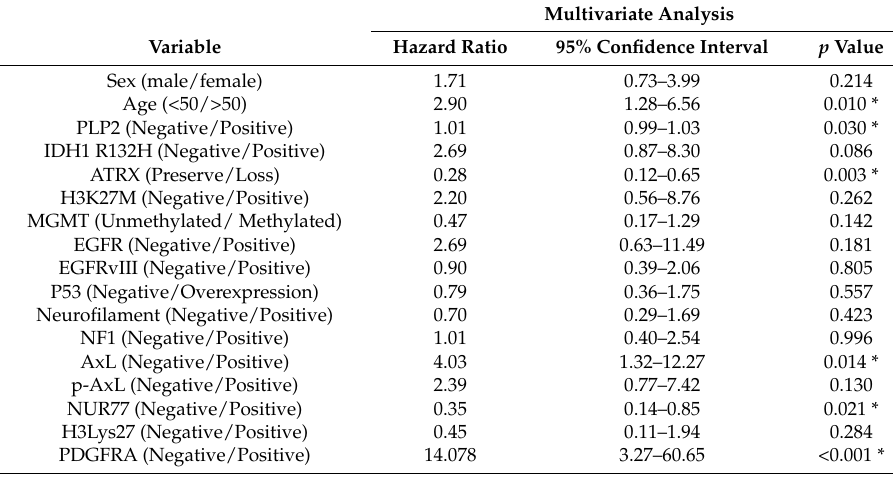
Figure 4. Relationships between overall survival rate and PLP2 immunostain scores in gliomas. Survival rates were analyzed using the Kaplan–Meier survival test (* p < 0.05). Table 3. Multivariate Analysis for Overall Survival in human brain Table 1. The correlation of PLP2 immunostain score with WHO grades of gliomas.